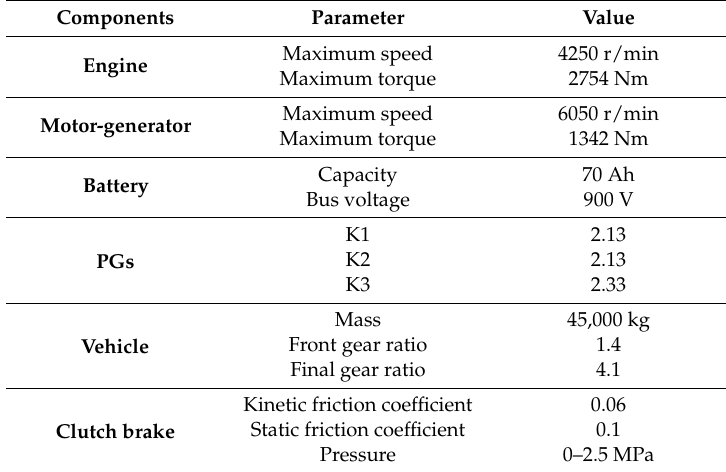
Table 2. Main parameters of the hybrid HDV with PST.